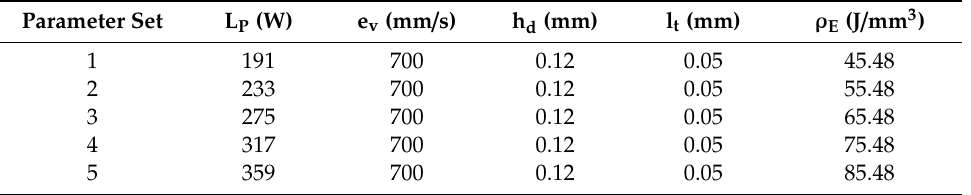
Table 3. Sets of analyzed production parameters.